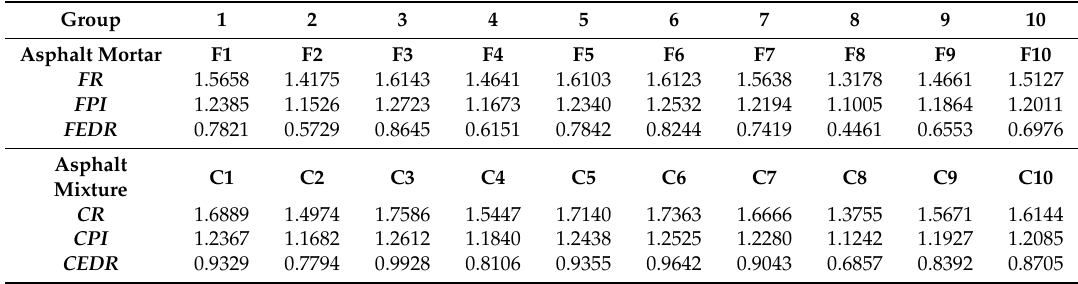
Table 7. Composite morphological index of fine and coarse